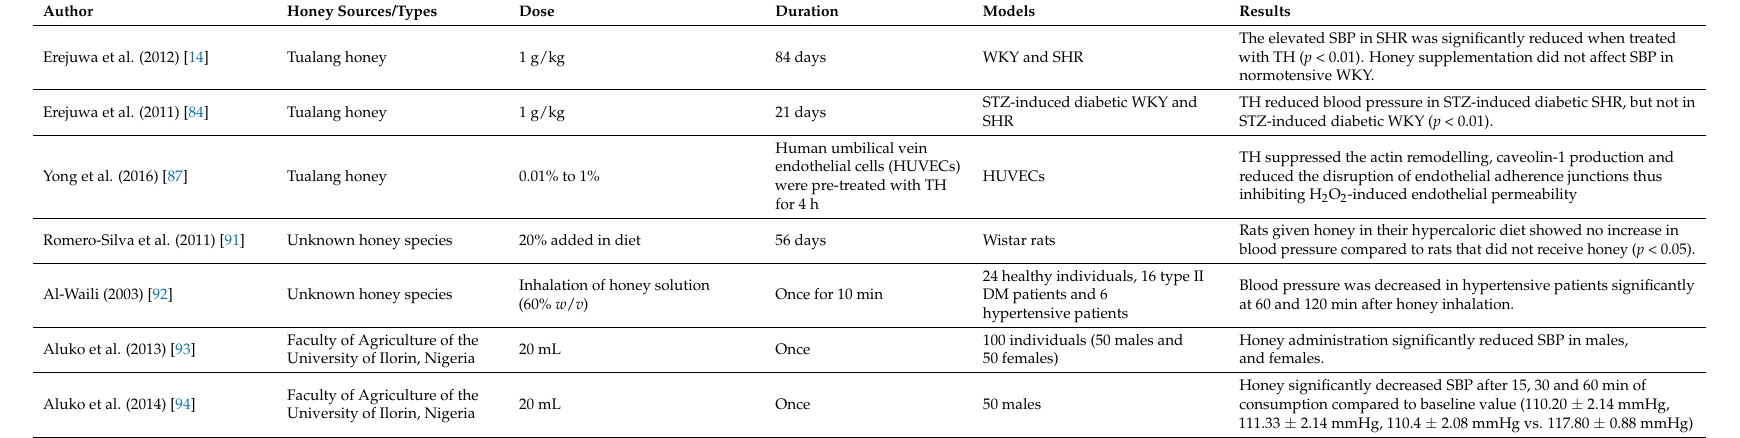
Table 4. Antihypertensive effects of honey in clinical and pre-clinical